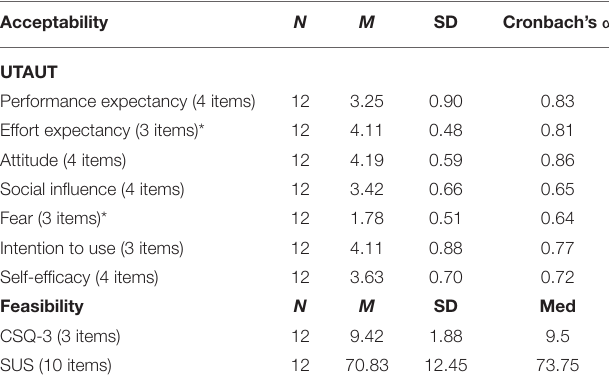
TABLE 3 | Descriptive statistics of